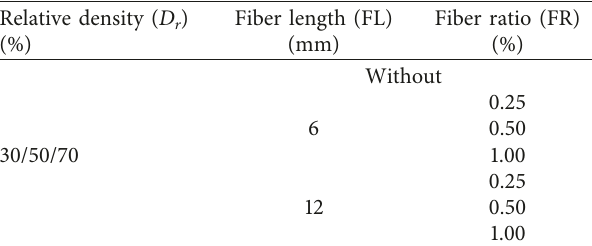
Table 1: Test cases conducted in this